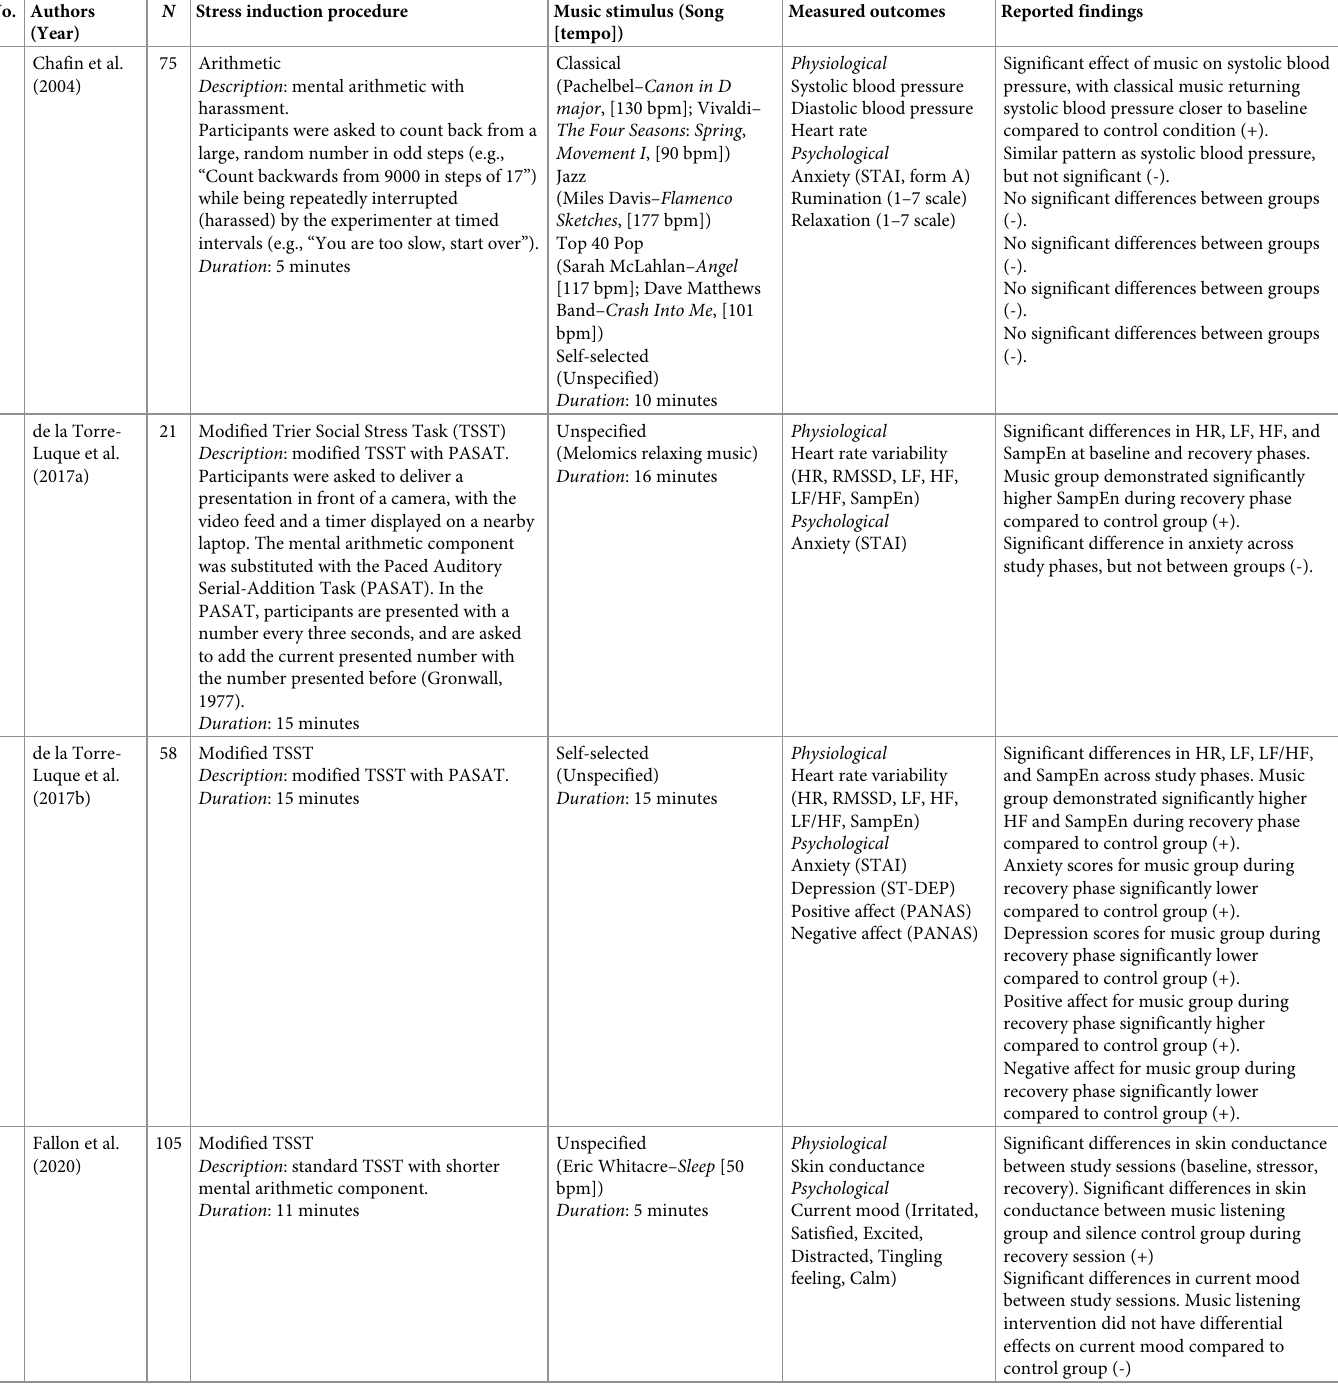
Table 4. Summary of studies included in the systematic